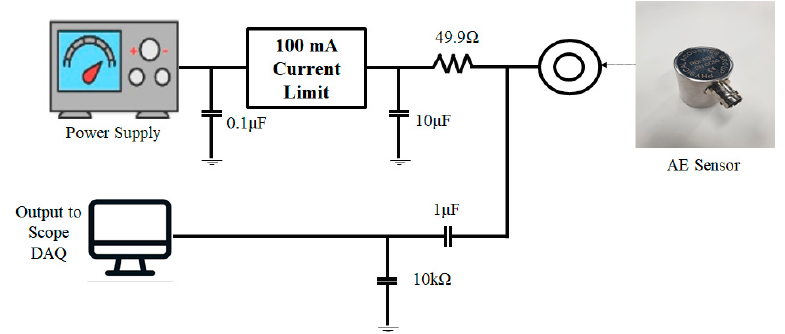
Figure 8. Driving circuit for AE sensor.